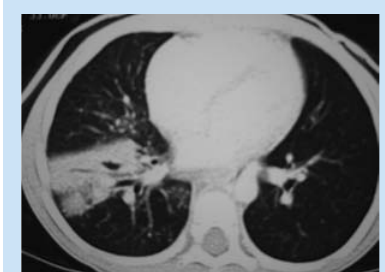
Fig. 2a. Metastases.